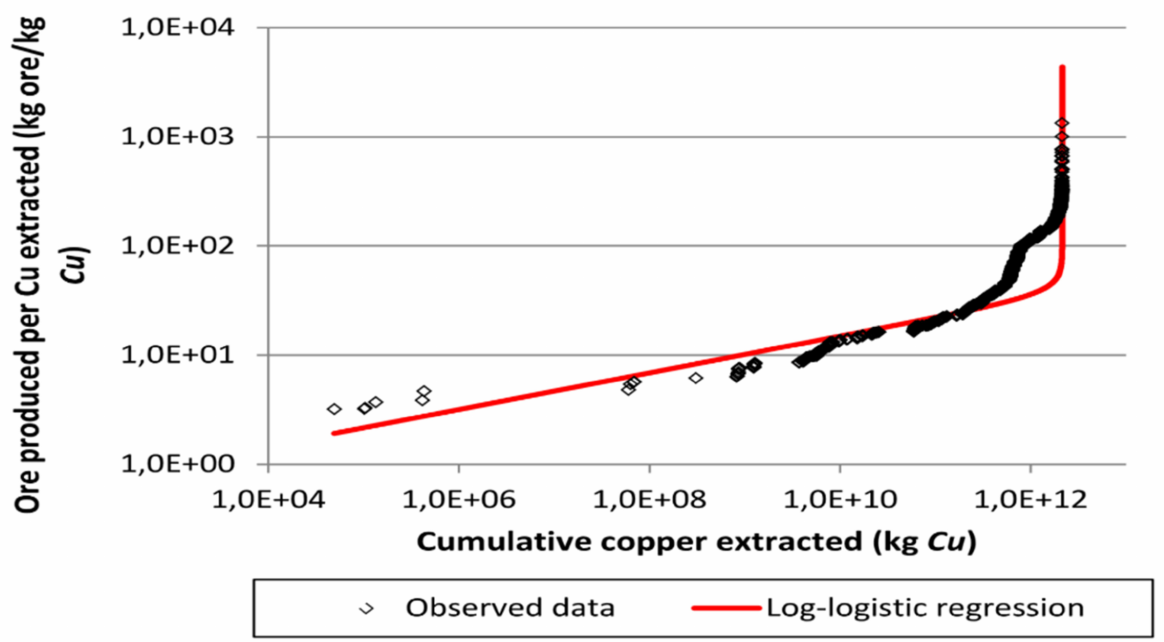
Figure 2. Cumulative grade-tonnage relationship for existing copper mines plotted using a log- logistic regression (in logarithmic scale)